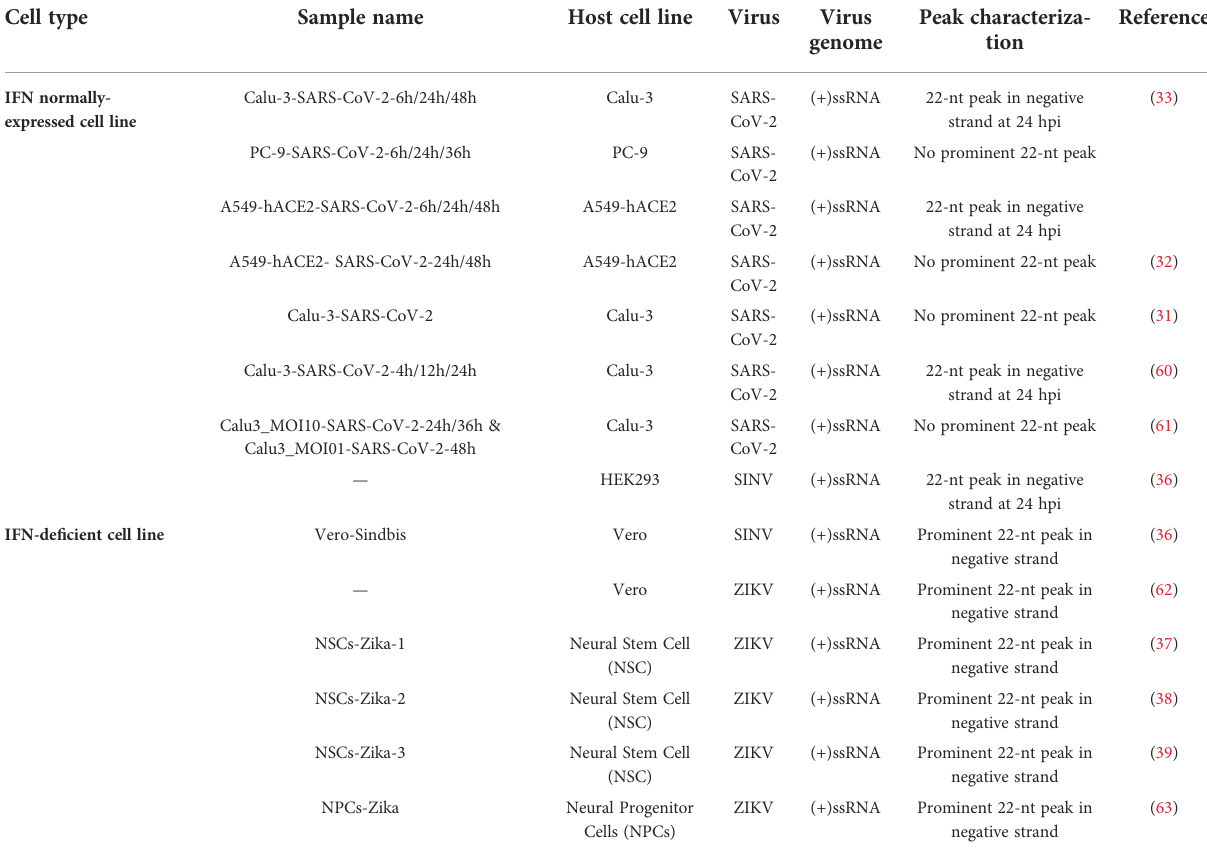
TABLE 1 The appears of 22-nt negative-strand peak of vsRNAs in different IFN-de fi cient or normally-expressed cell lines infected with different